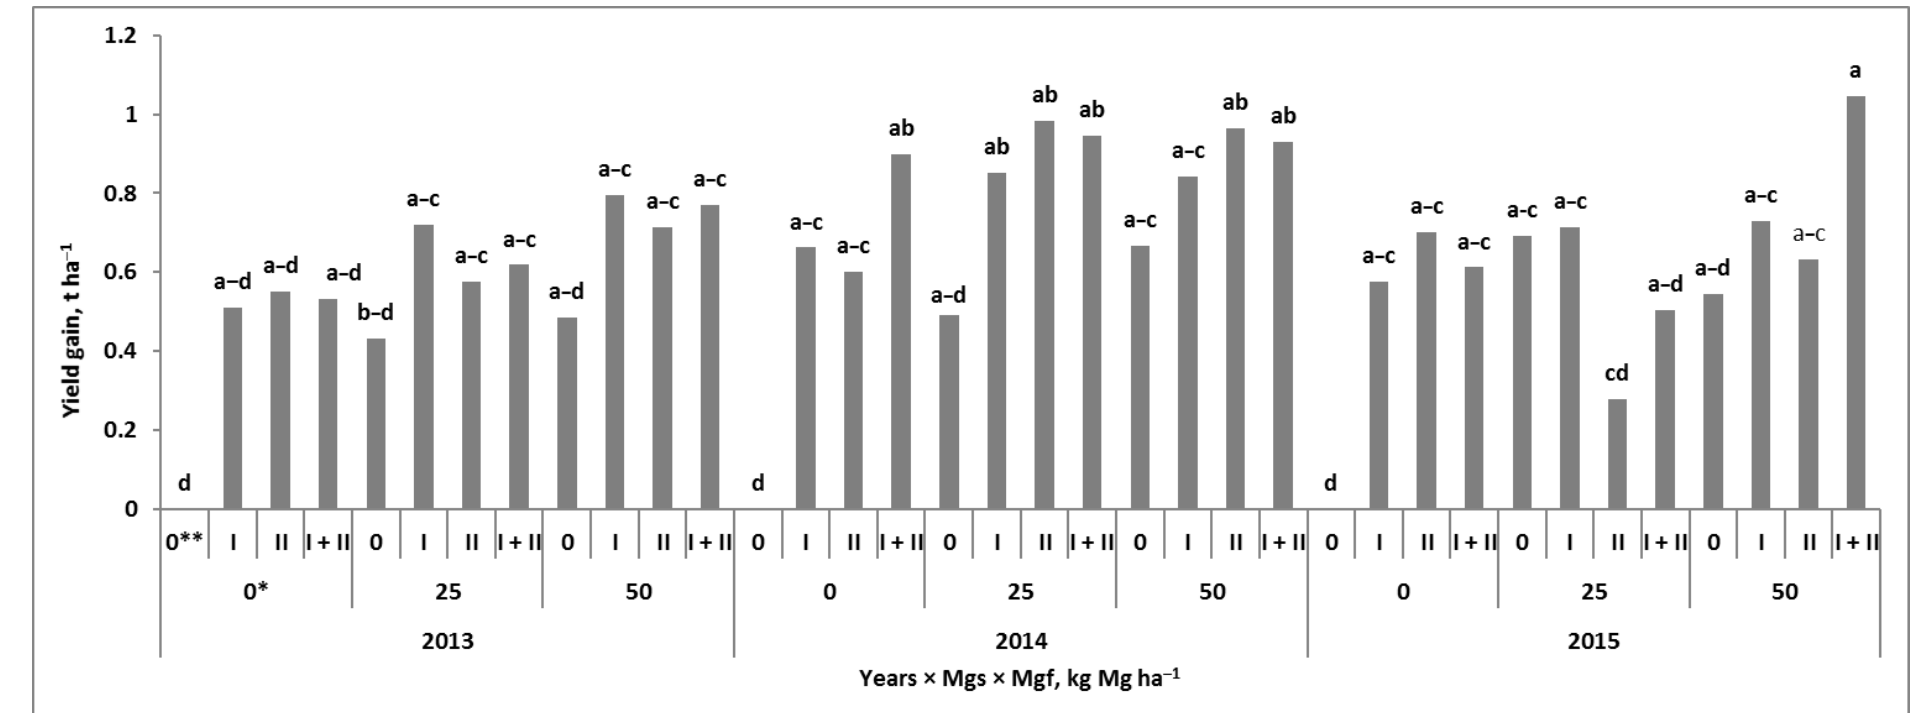
Figure A1. The increase in the yield of winter wheat in response to the interaction of years and Mg fertilization systems. a, b, c, d Similar letters mean a lack of significant differences using Tukey’s test. Mgs and Mgf—soil and foliar Mg fertilization systems, respectively. * Doses of soil-applied Mg, kg ha − M ; ** stages of Mg foliar fertilization to wheat: I — BBCH 30; II — BBCH 49/50.